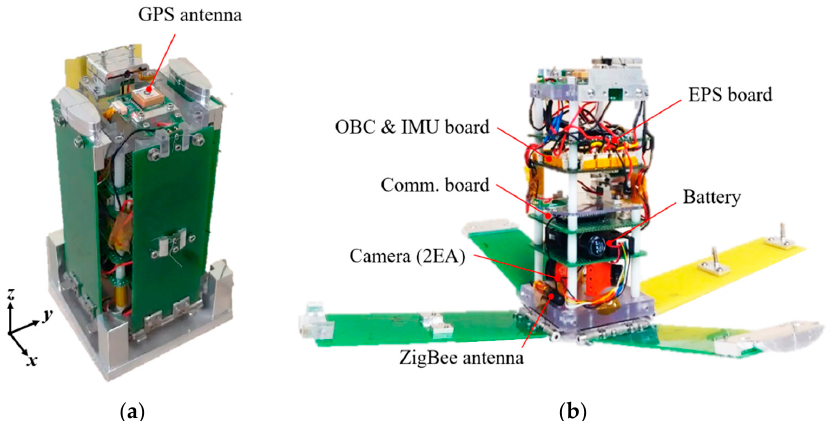
Figure 10. Flight model of the DHRM CanSat showing the ( a ) stowed and ( b ) deployed solar panels. Figure 11a,b show the release function test setup of the proposed HRMs in the flight model of the CanSat before and after deployment of the solar panels, respectively. The tests were performed at ambient room temperature. The mechanisms were activated when the OBC received a deployment command signal from the ground station, and all the solar panels were successfully deployed as intended, as shown in Figure 11b.